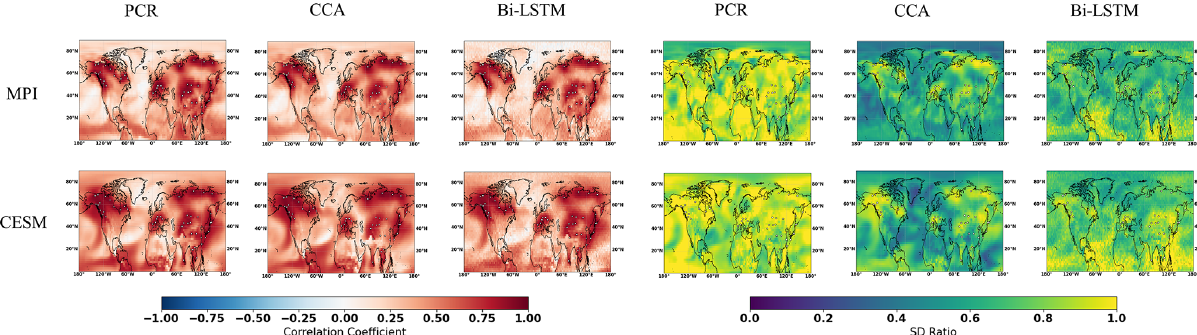
Figure 5. NH reconstruction results of CFR methods (including PCR, CCA, and Bi-LSTM) using MPI and CESM numerical simulation as target temperature field. All of the CFR methods employ the same proxy network with the full set of 48 ideal pseudoproxies that span the same reconstruction period from 850 to 1899CE. The employed pseudoproxies geolocations based on tree ring width (TRW) are shown as white circles in all panels. CC is correlation coefficient, and SD represents standard